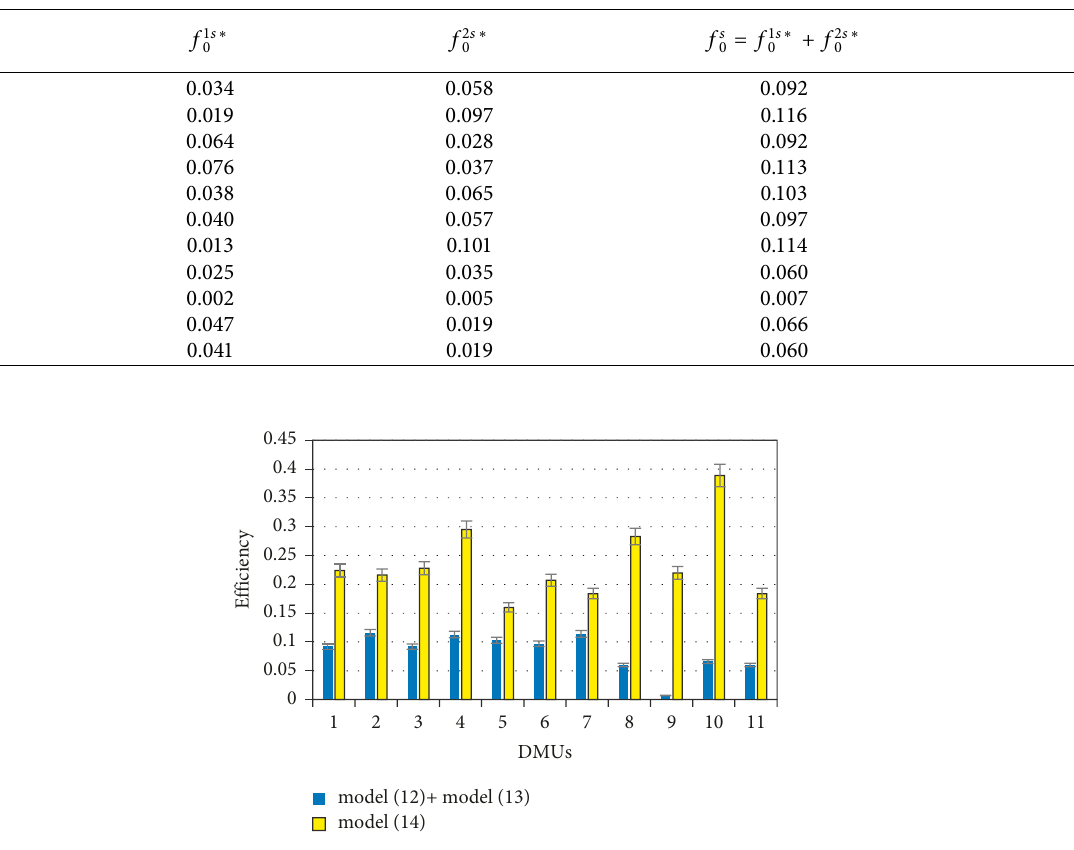
Figure 3: Comparison of the overall efficiency with model (14).